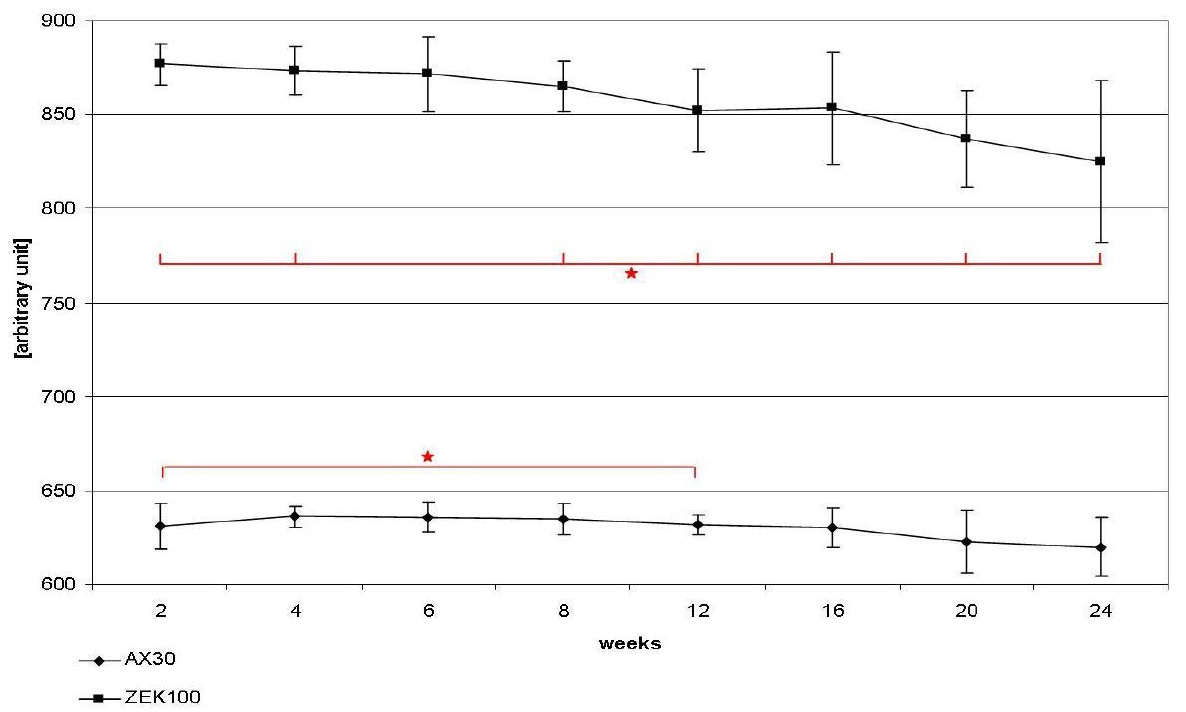
Figure 2. Changes of the apparent density of the implants during implantation measured by the in vivo